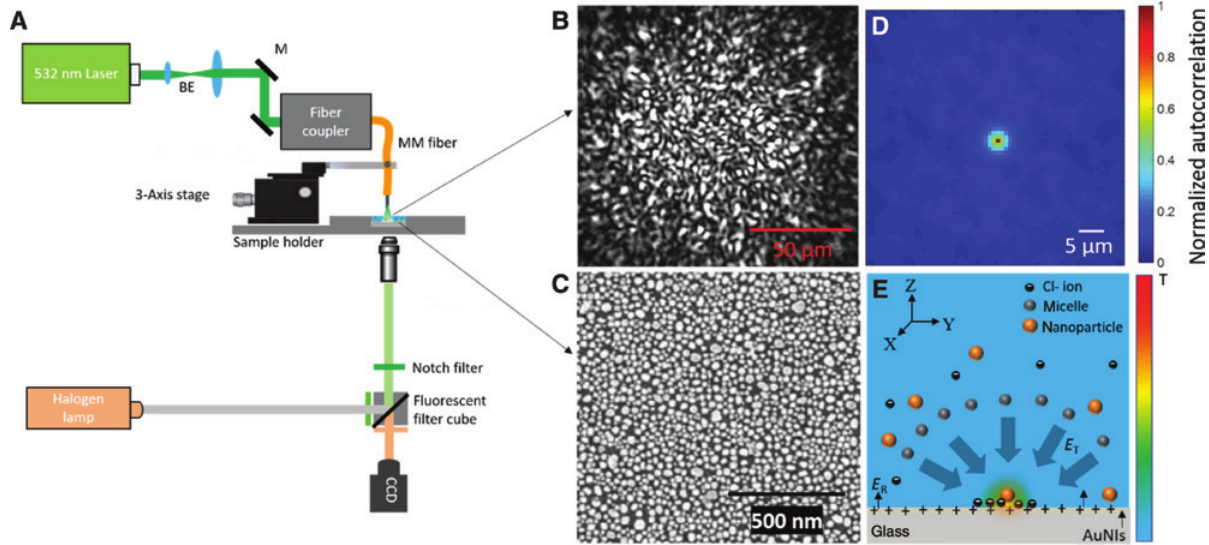
Figure 1: Opto-thermoelectric speckle tweezers. (A) Schematic of the experimental setup of opto-thermoelectric speckle tweezers (BE: beam expander, M: mirror, CCD: charge-coupled device). (B) Optical image of a typical speckle light pattern generated at the output of an MM fiber with a diameter of 105 μ m. (C) Scanning electron microscope image of a plasmonic AuNIs substrate. (D) Normalized spatial